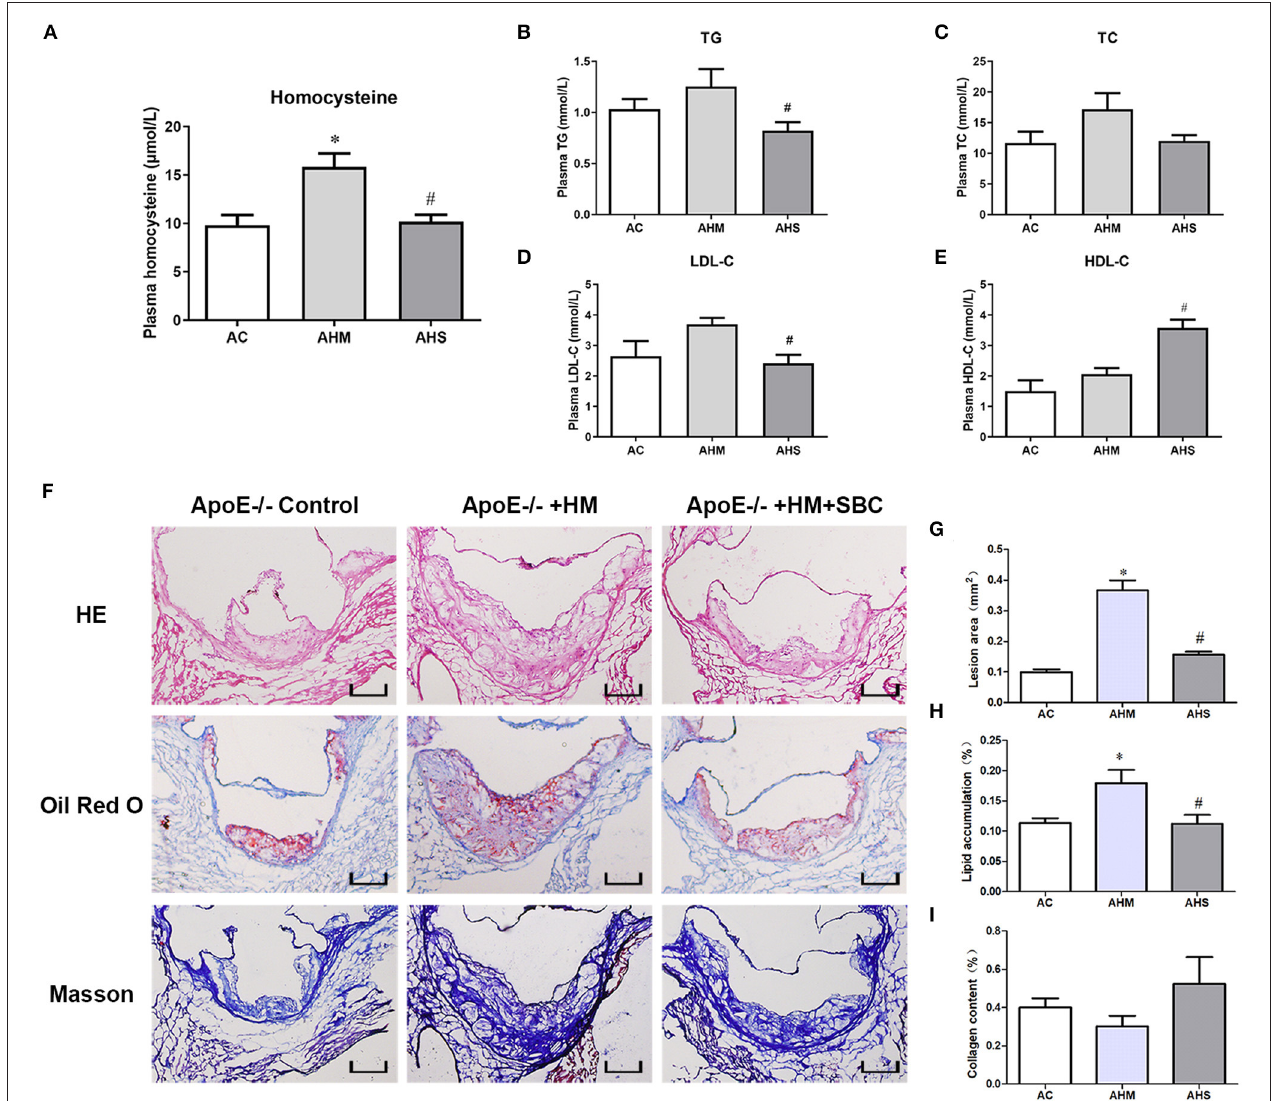
FIGURE 4 | SBC-115076 decreased plasma Hcy and lipid levels and ameliorated atherosclerotic lesions in ApoE − / − mice with HHcy. Levels of plasma Hcy (A) and lipid profiles among three groups were measured (B–E) . Histology (F) and quantification of HE staining (G) , Oil-red O staining (H) and Masson staining (I) in aortic roots. Data represent mean ± standard error of the mean (SEM) ( n = 12 in each group). * p < 0.05 vs. control group (AC group). # p < 0.05 vs. HHcy group (AHM group). Hcy, homocysteine; HHcy, hyperhomocyteniemia; HM, methionine; SBC, SBC-115076; TG, triglycerides; TC, total cholesterol; LDL-C, low-density lipoprotein cholesterol; HDL-C, high-density lipoprotein cholesterol; AC, ApoE − / − mice with chow diet; AHM, ApoE − / − mice with methionine treatment; AHS, ApoE − / − mice with methionine + SBC treatment. Scale bar = 100 µ